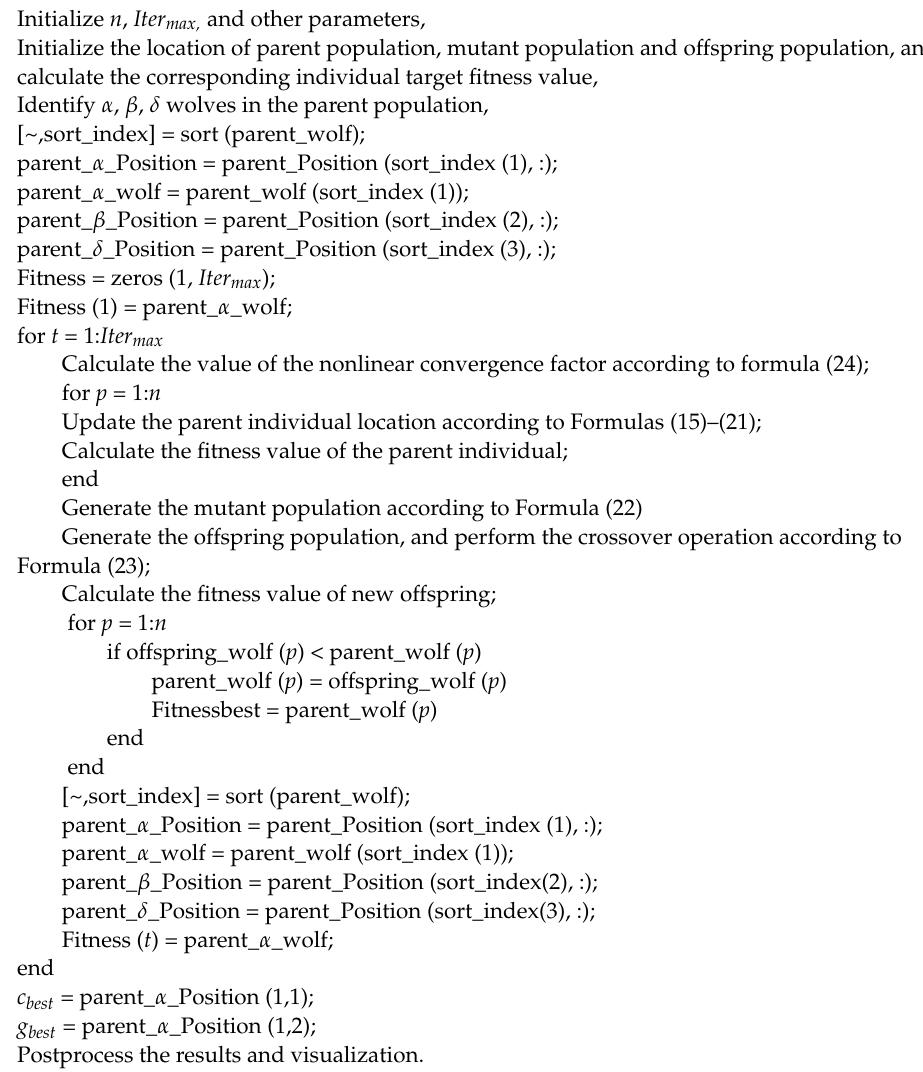
Algorithm 1. The pseudocode of the IGWO optimization